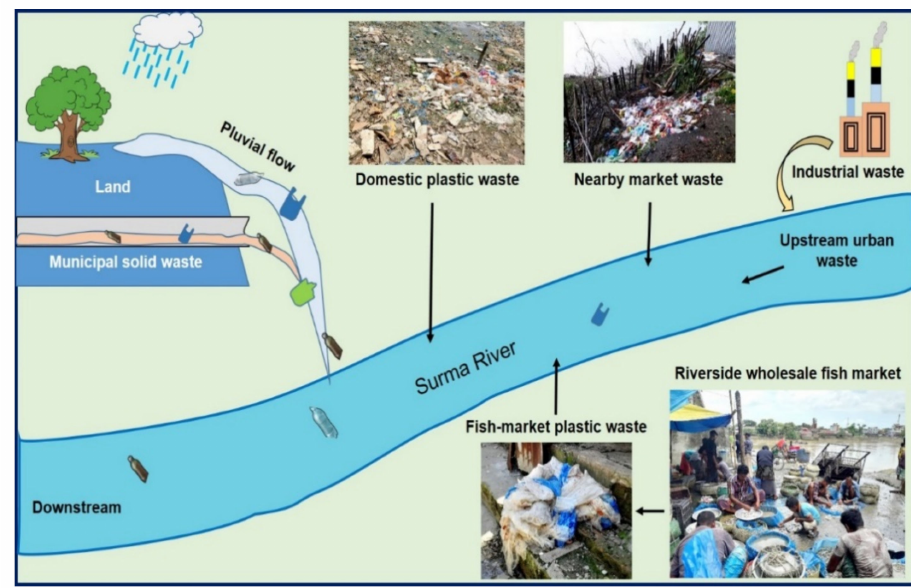
Figure 10. Schematic diagram of the major sources of plastic pollution in the Surma River.